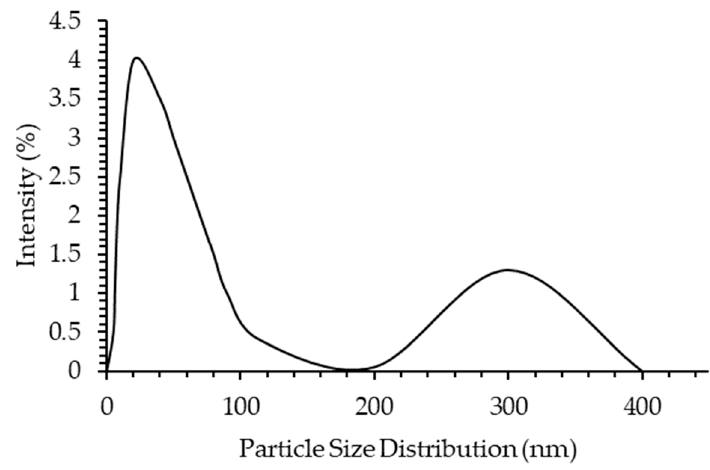
Figure 8. Particle size distribution. [C 16 C 1 Pip] 2 [LS] treated model oil.